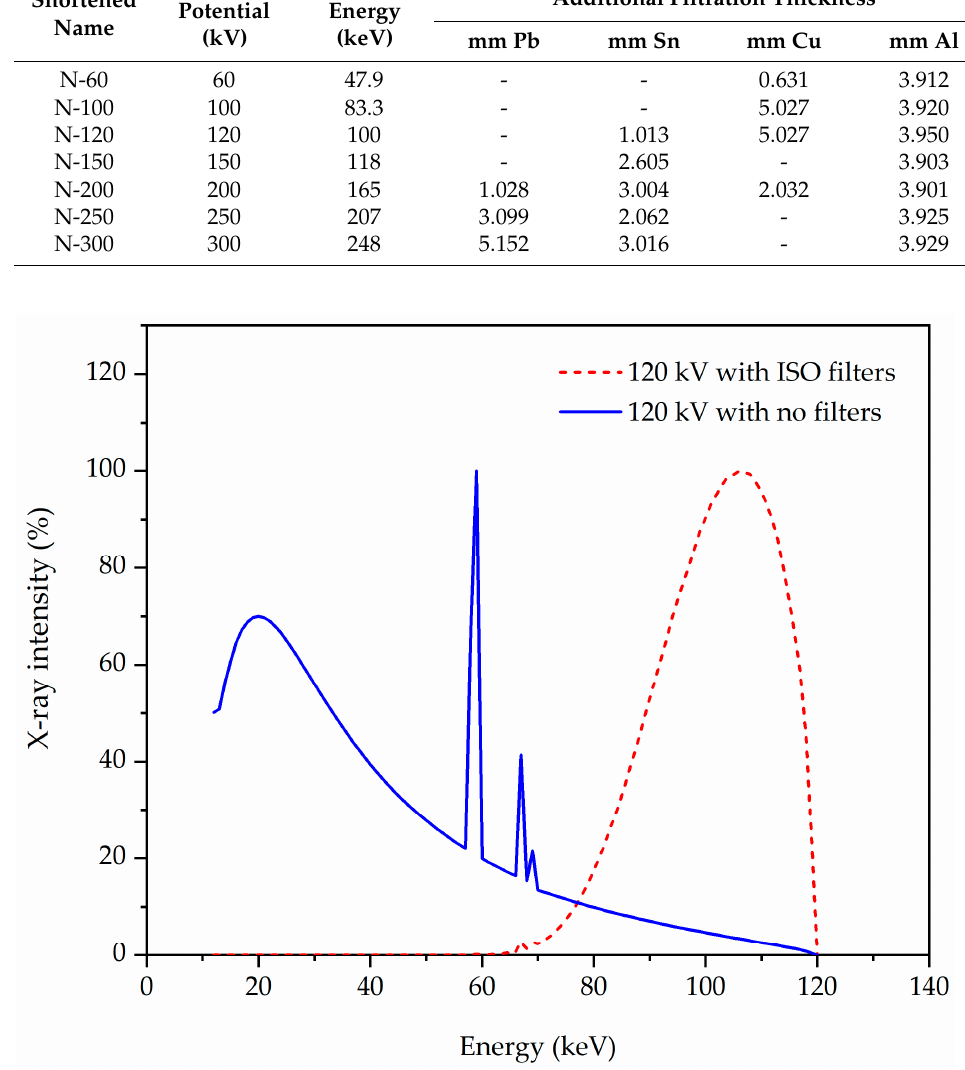
Figure 6. The distribution of the number of X-rays for 120 kVp extracted from SpekCalc with no filters and with ISO filter.